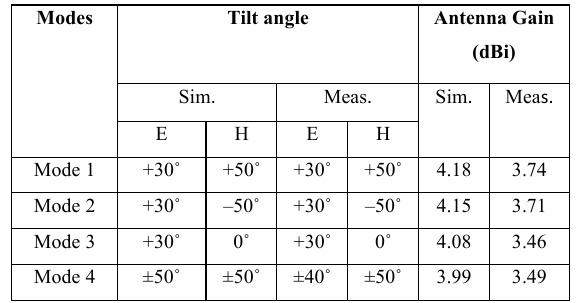
TABLE III. Simulated and measured results of beam tilt angle and antenna gain for various reconfiguration modes.